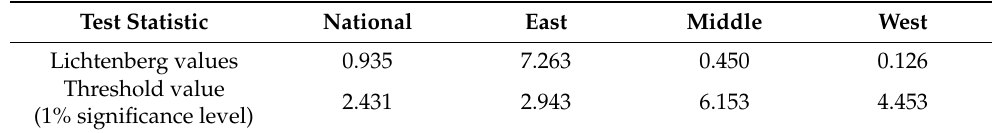
Table 6. Results of σ convergence test for the whole country and different regions. Test Statistic National East